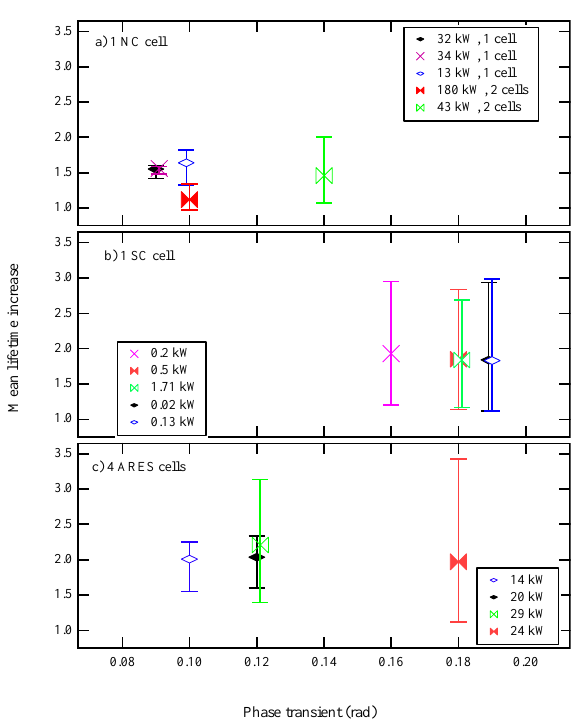
FIG. 11. (Color) Lifetime improvement versus total bunch syn- chronous phase transient computed for various generator powers with active harmonic cavities on the ALS ring with a 17% gap at 400 mA. (a) One and two NC cavities. (b) One SC cavity. (c) Four ARES-type